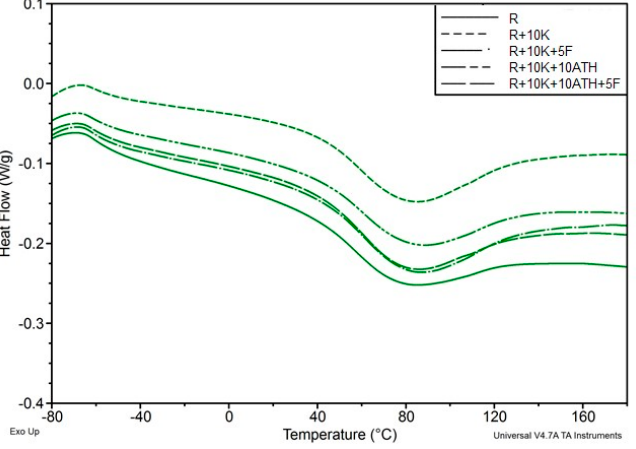
Figure 4. Comparison of DSC thermograms of foams with ATH, keratin and Fyrol with reference foam